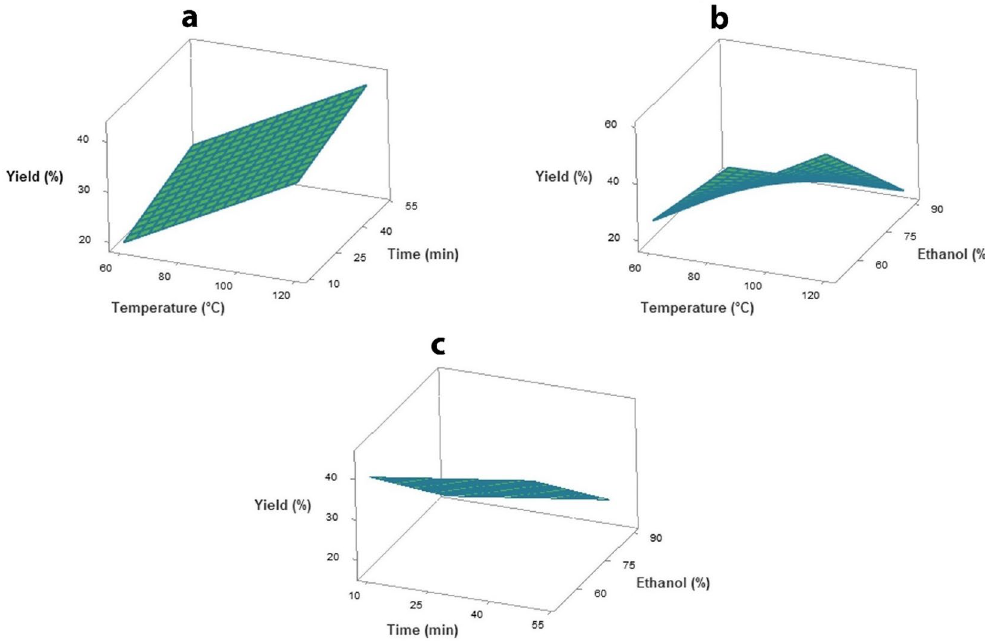
Figure 2. Response surface plots as a function of independent variables on the extraction yield. ( a ) temperature and extraction time, ( b ) temperature and ethanol concentration, and ( c ) extraction time and ethanol